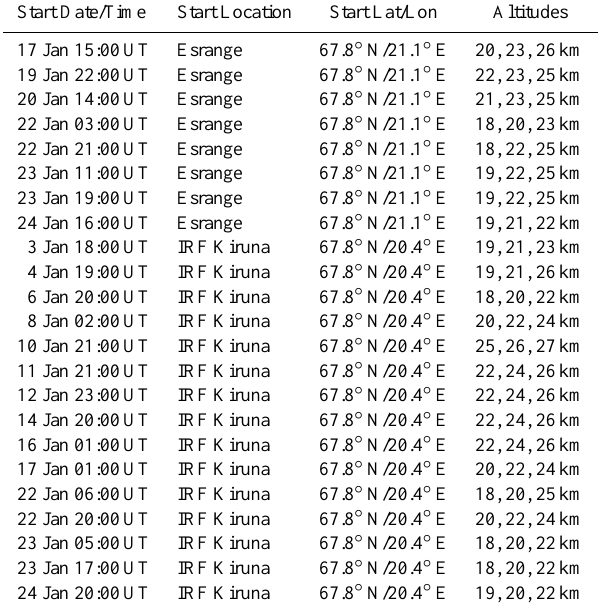
Table 3. Starting dates and times of the trajectories calculated with HYSPLIT. The starting dates and times have been chosen based on the measurements with the Esrange and IRF